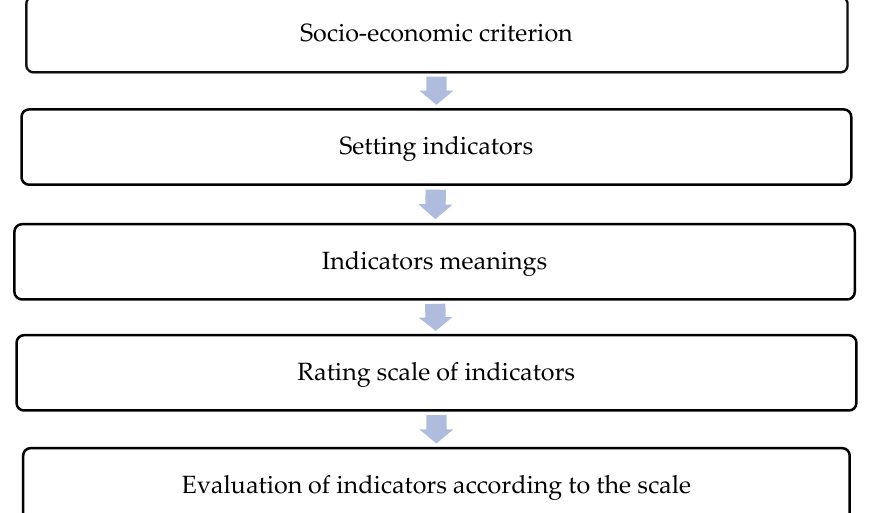
Figure 1. Socio-economic criteria assessment scheme [22–28]. Indicators detail each criterion. Each socio-economic criterion is characterized by ten indicators: forest holdings, contribution of forest sector to GDP, net revenue, investments